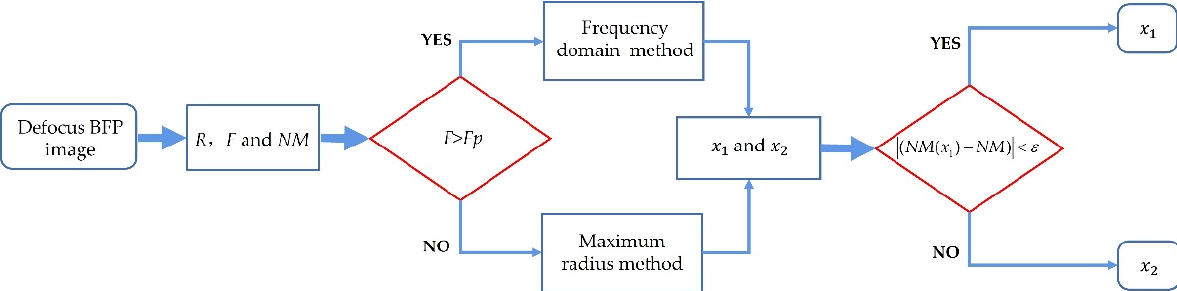
Figure 5. Flow chart of the proposed defocus position determination algorithm. A complete BFP image undistortion and ellipsometric error compensation example